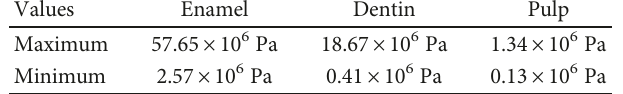
Table 7: 4th degree caries : von Mises stresses results.